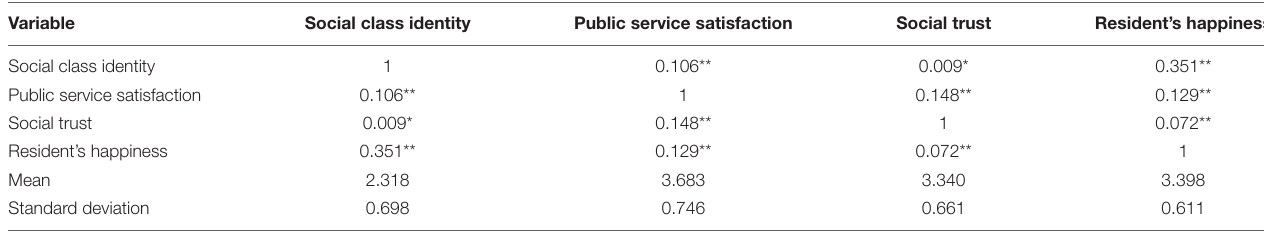
TABLE 3 | Descriptive statistics and correlation test of variables.